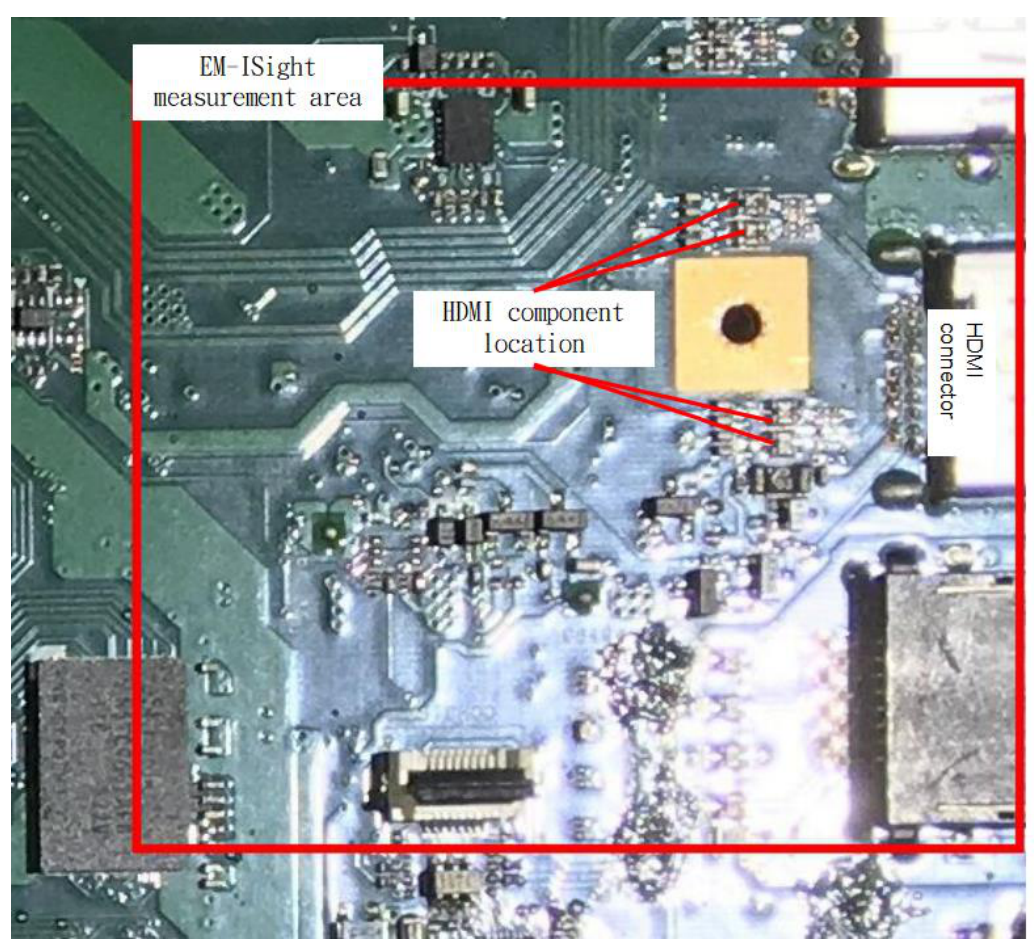
Figure 17. The improved near field measurement area diagram of HDMI layout.